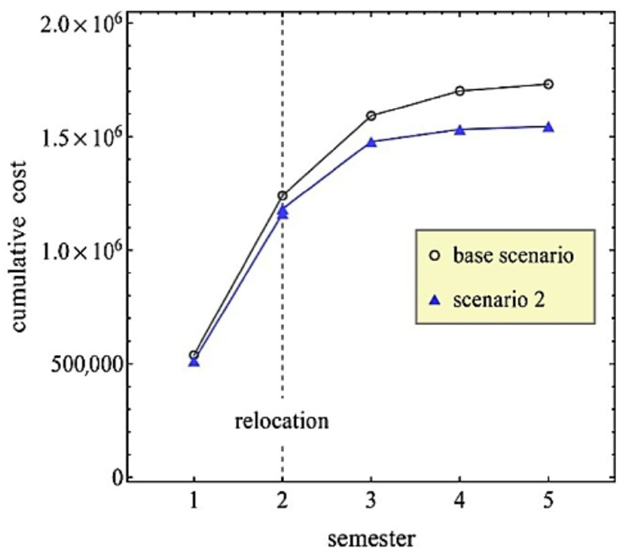
Figure 11. Comparison of cumulative costs between scenarios.